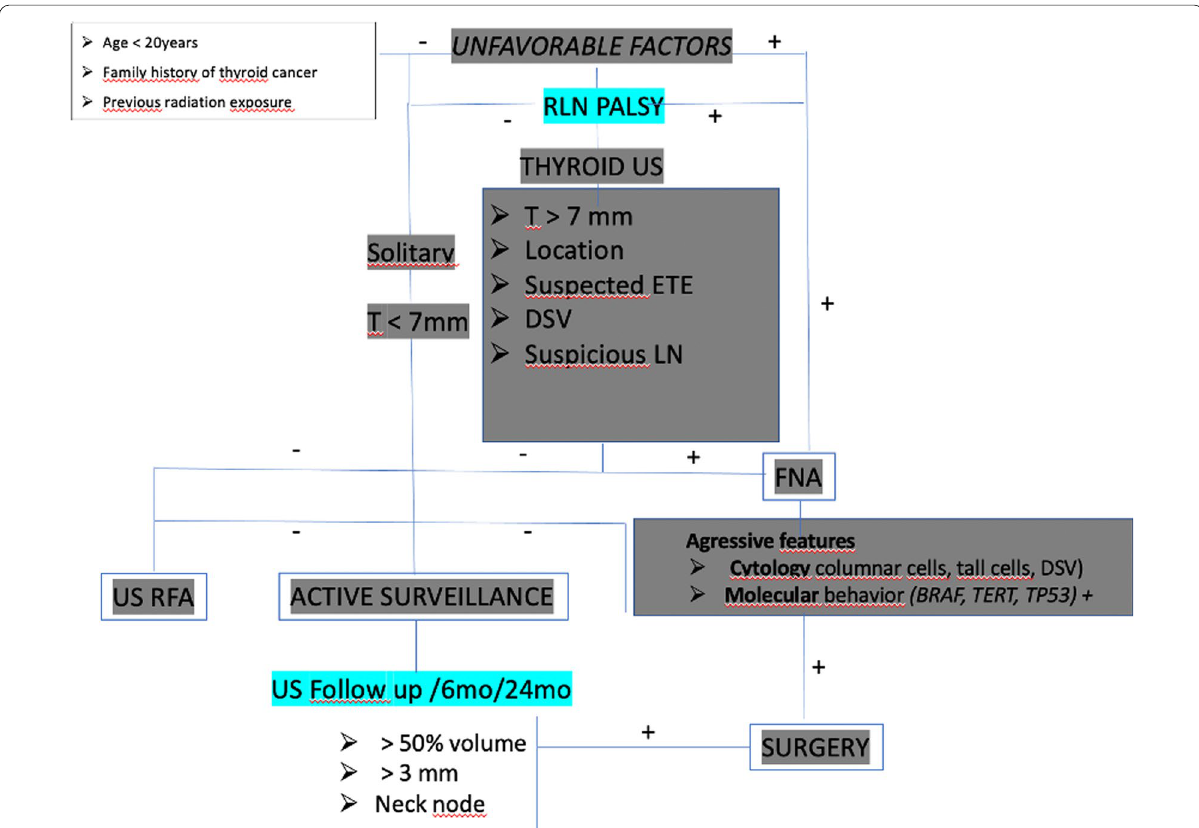
Fig. 5 Decision algorithm regarding PTC. Thyroid US is central in decision algorithm of small size PTC. Unfavourable factors, including young age < 20 years, previous radiation exposure and family history of thyroid cancer [18], and recurrent laryngeal nerve (RLN) palsy should lead to